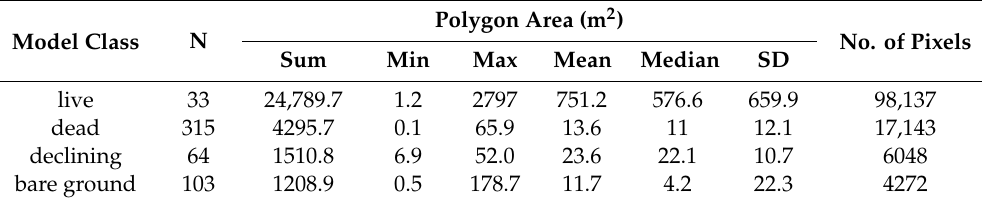
Table 1. Reference polygons, their number / size per class, and the amount of pixels available for training and validation on “pure classes” after converting polygon areas into raster maps with 0.5 m